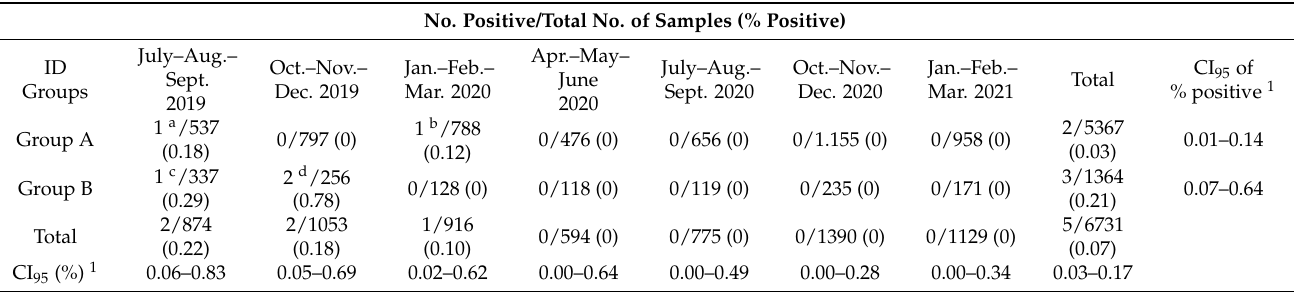
Table 4. Salmonella spp. in ready-to-eat food, from July 2019 to March 2021. No. Positive/Total No. of Samples (%